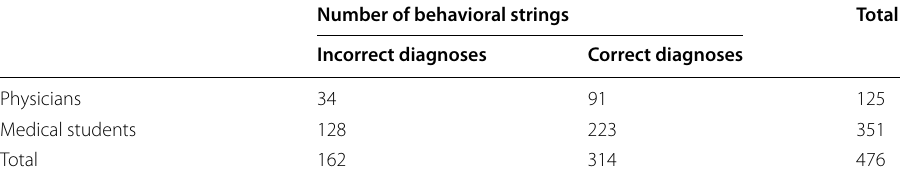
Table 1 Distributions of Incorrect and Correct Diagnoses Across Behavioral Strings of Physicians and Medical